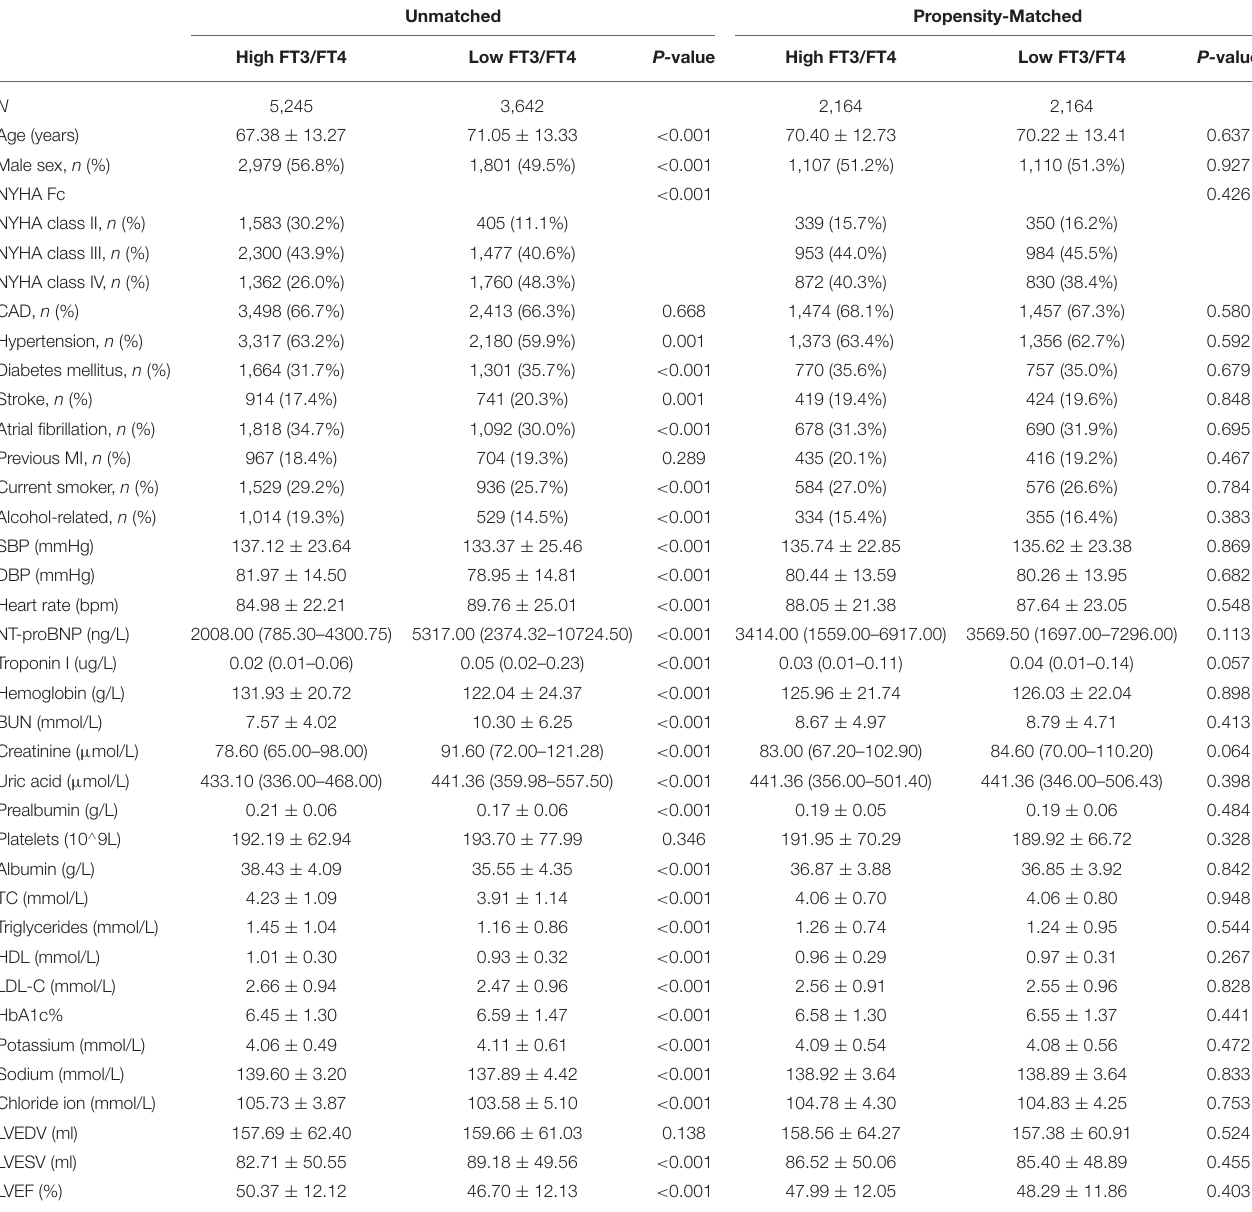
TABLE 1 | Baseline characteristics of patients in the high and low FT3/FT4 ratio groups before and after propensity matching. Unmatched Propensity-Matched High FT3/FT4 Low FT3/FT4 P- value High FT3/FT4 Low FT3/FT4